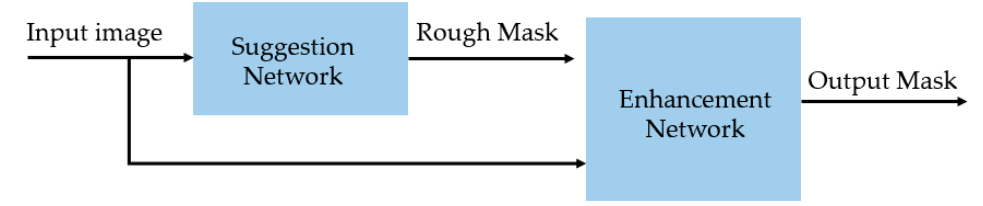
Figure 2. Overall network architecture .